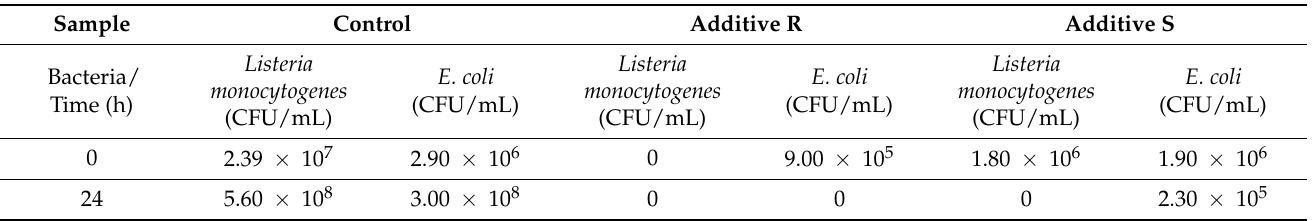
Table 2. Colony forming units (CFU) for Petri dishes: control, additive R148 and additive S254.